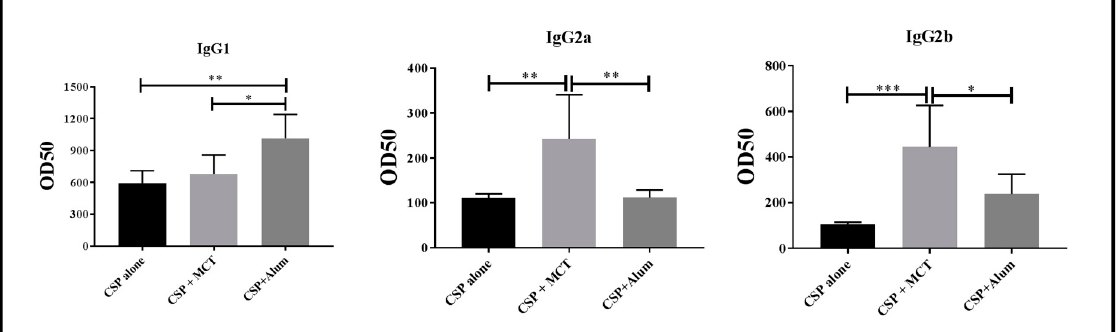
Figure 5. Assessment of relevant subclasses of IgG antibodies (IgG1, IgG2a, IgG2b). Mice were immunized as described in Figures 3 and 4 and subclass specific IgG responses were determined on day 35. The results were analyzed using GraphPad Prism software applied to compare the means of groups by Tukey’s Multiple Comparison Test of one-way ANOVA. *** p value < 0.0001; ** p value < 0.001; * p value < 0.01.